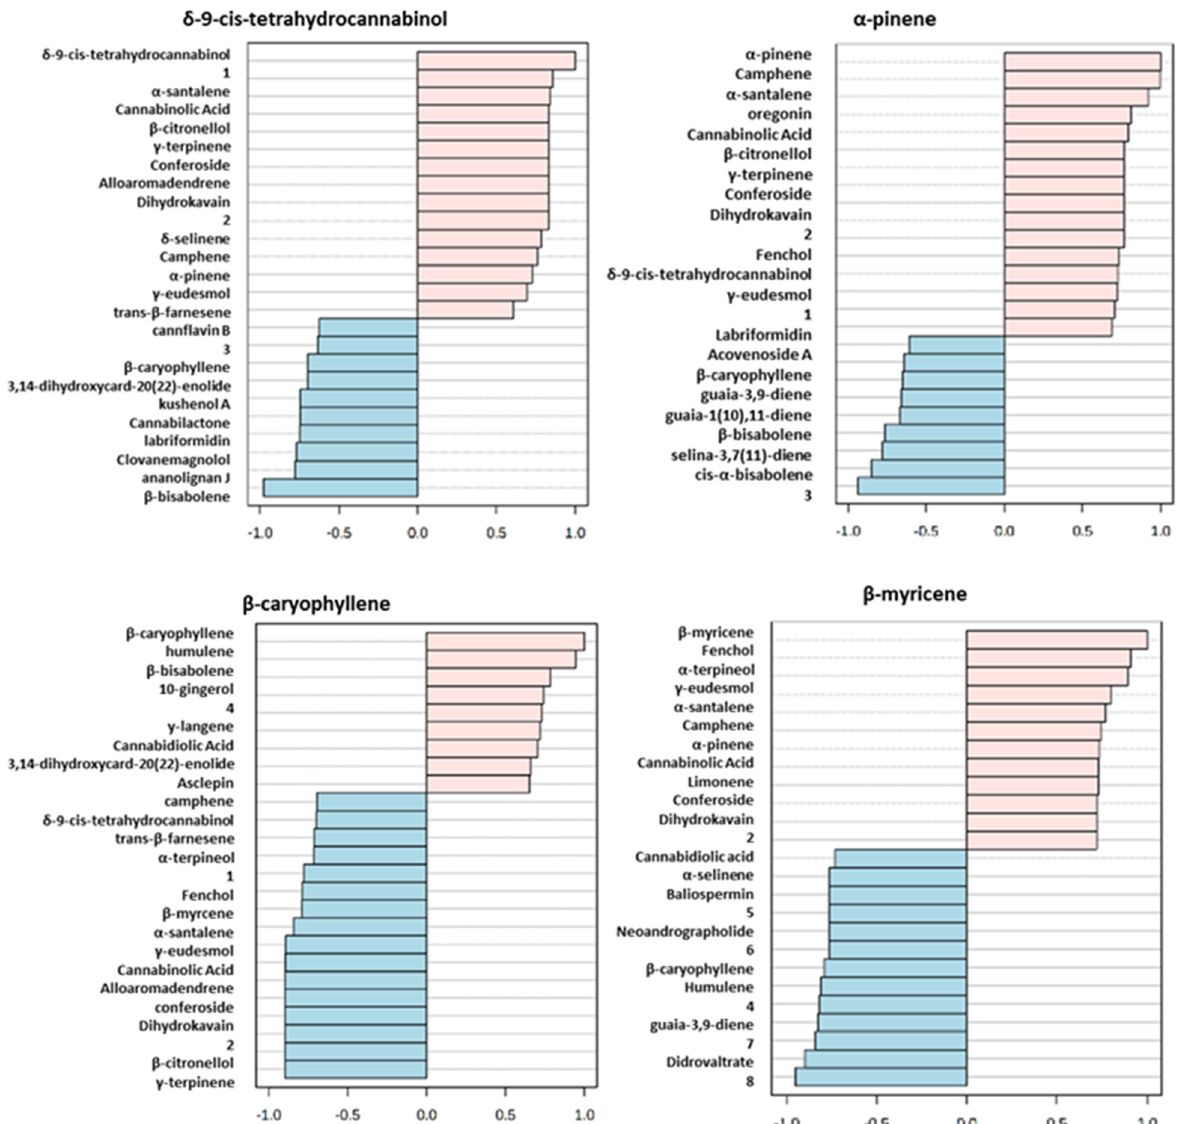
Figure 5. Analysis of the top 25 correlated compounds based on Pearson Correlation Coefficient for δ -9-cis-tetrahydrocannabinol, α -pinene, β -caryophyllene, β -myrcene. The numbers in the figure rep-